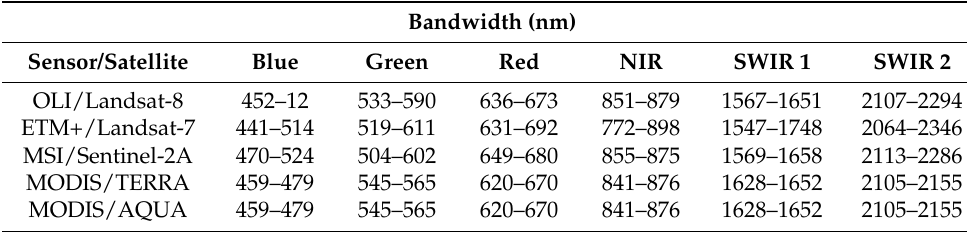
Table 1. Spectral bands of satellite